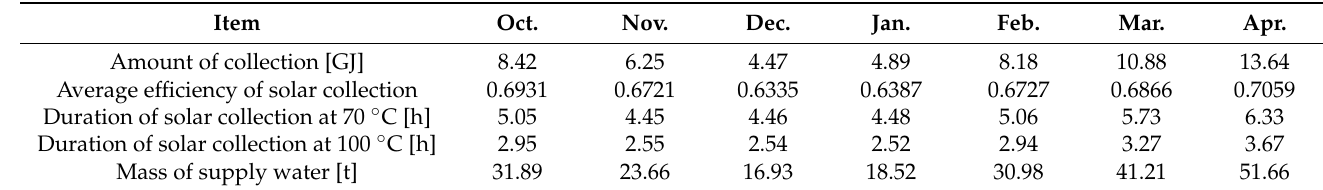
Table 4. Simulation results for a typical day of each month in the heating season.